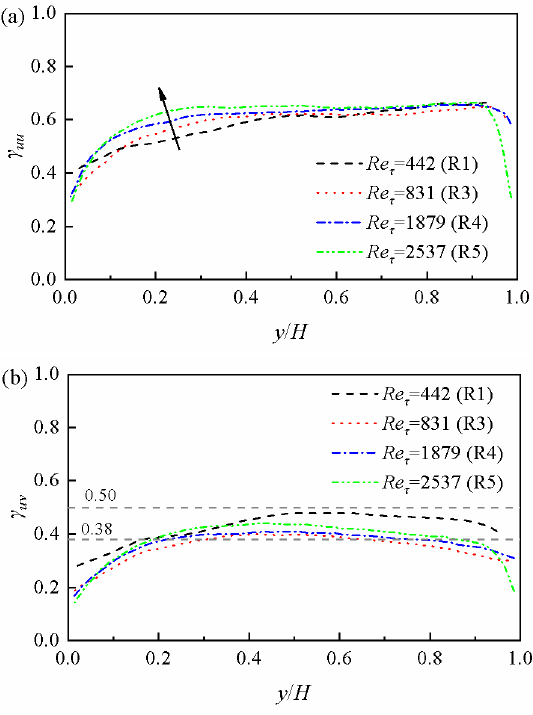
Figure 6. ( a ) Streamwise kinetic energy fraction and ( b ) Reynolds stress fraction contributed by VLSMs, using 3 H as a separation scale.